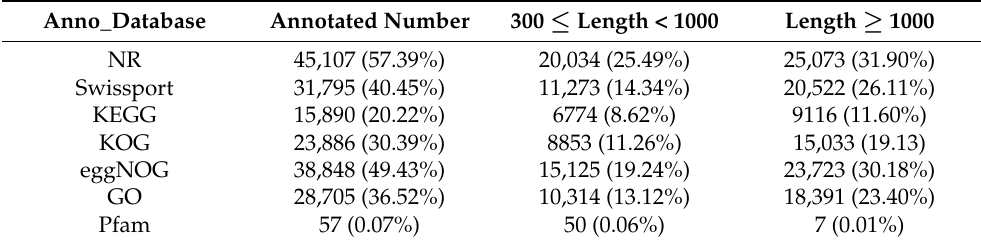
Table 3. Summary statistics of unigenes annotated by different